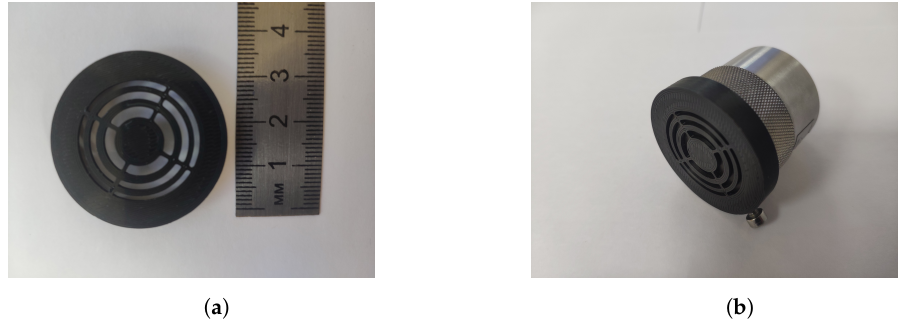
Figure 7. Photographs of the designed and implemented lens. ( a ) Manufactured PR-FZP; ( b ) PR-FZP placement on the